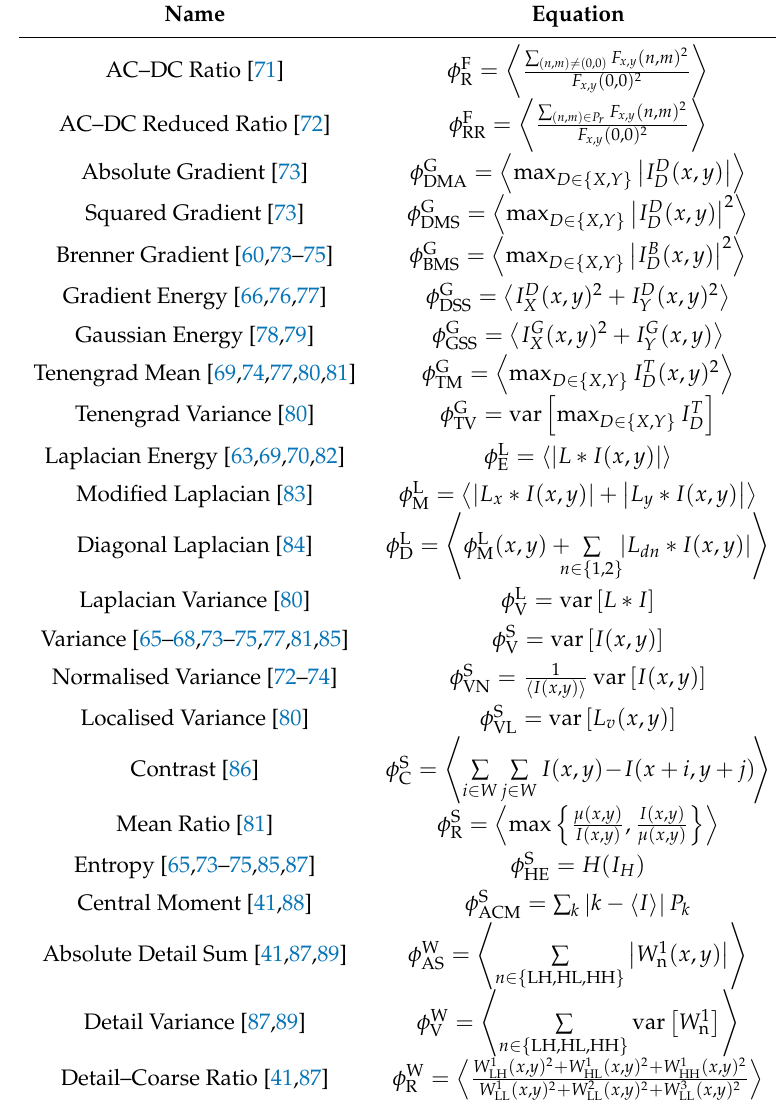
Table 1. Summary of the names, abbreviations and methods of action. var [ X ] represents the variance of X across the imaging area, and (cid:104) X (cid:105) represents the mean of X across the imaging area. Name